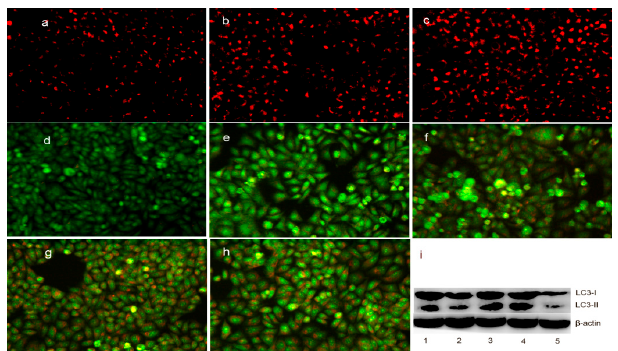
Figure 8. DpdtpA and its copper complex induced autophagy (or changes in LMP) in HepG2 cells: